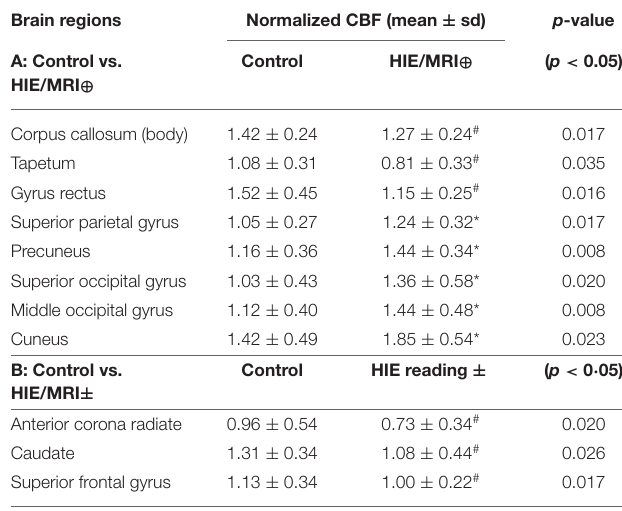
TABLE 2 | Brain regions with significant perfusion differences between control and HIE/MRI ⊖ groups, and between HIE/MRI ⊖ and HIE/MRI ⊕ groups. Brain regions Normalized CBF (mean ± sd)